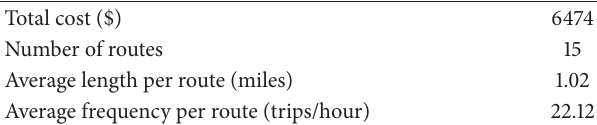
Figure 1: Optimal network under M-to-1. Table 2: Solution indicators under